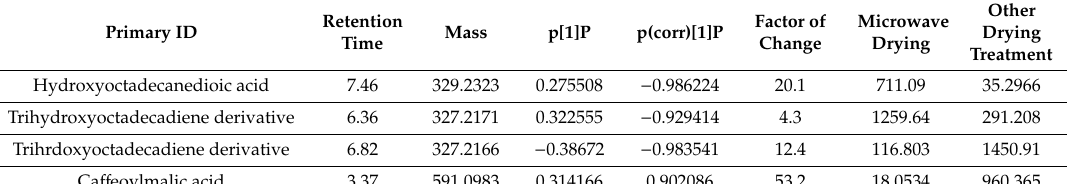
Table 8. Exact Mass/Retention Time pairs responsible for the separation of microwave dried Nightshade leaves and other samples that underwent solar, oven, microwave and freeze-drying treatments.